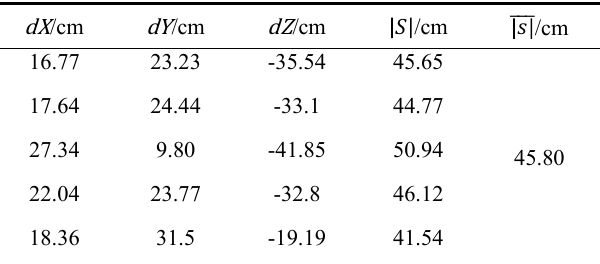
Figure 12 . Displacement of deformation trend.